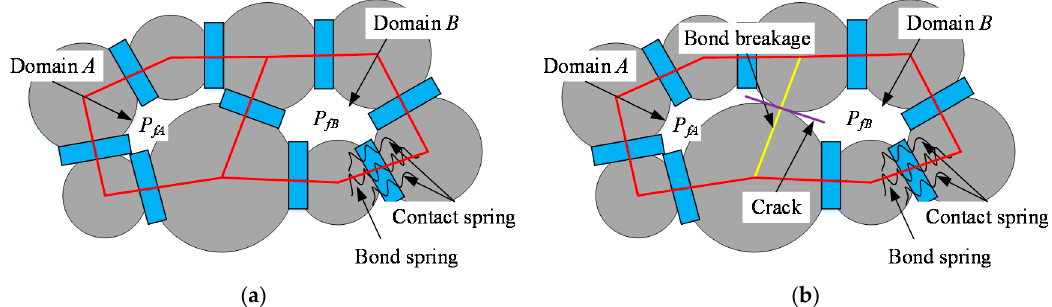
Figure 6. Bond breakage and fluid pressure balancing according to Equation (23) in the two domains: ( a ) fluid pressure before a crack initiation and ( b ) fluid pressure after a crack initiation.